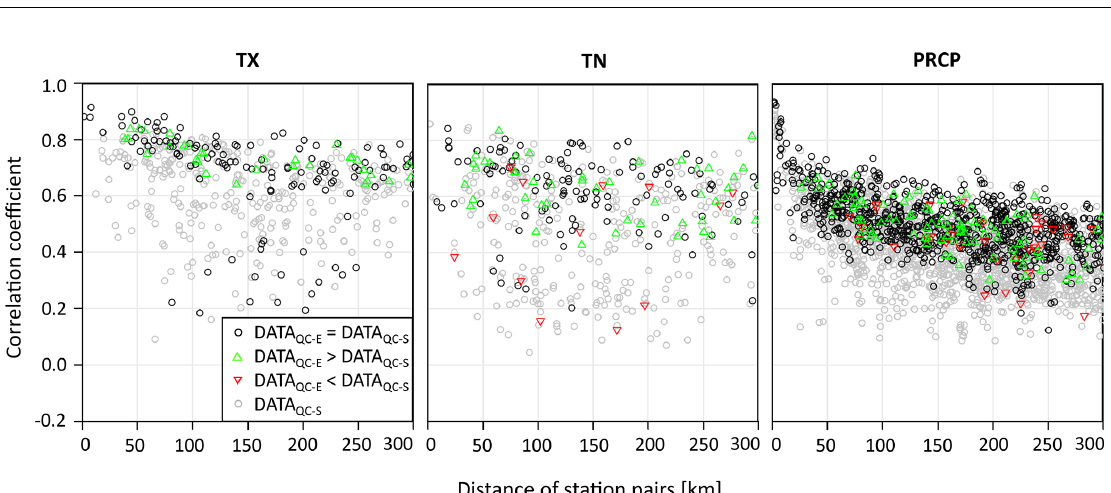
Figure 3. Correlation coefficients of station pairs as a function of station distance for maximum temperature (TX), minimum temperature (TN), and precipitation (PRCP). This figure shows the example of monthly correlations in the Altiplano ( ≥ 3500ma . s . l . ). Black circles indicate equal correlation coefficients in DATA QC-S and DATA QC-E (absolute difference ≤ 0 . 01), grey circles indicate correlation coefficients of station combinations of DATA QC-S that do not occur in DATA QC-E (or the absolute difference to the equivalent in DATA QC-E is > 0 . 01), green triangles show correlation coefficients of DATA QC-E that are higher than in DATA QC-S (difference > + 0.01), and red triangles show correlation coefficients of DATA QC-E that are lower than DATA QC-S (difference < −